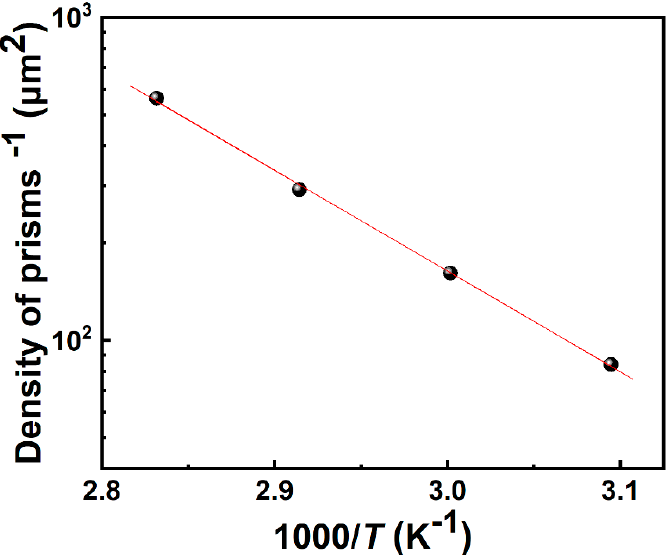
Figure 3. The inverse density of prisms plotted as a function of the reciprocal of temperature following the Arrhenius plot fit. the Arrhenius plot